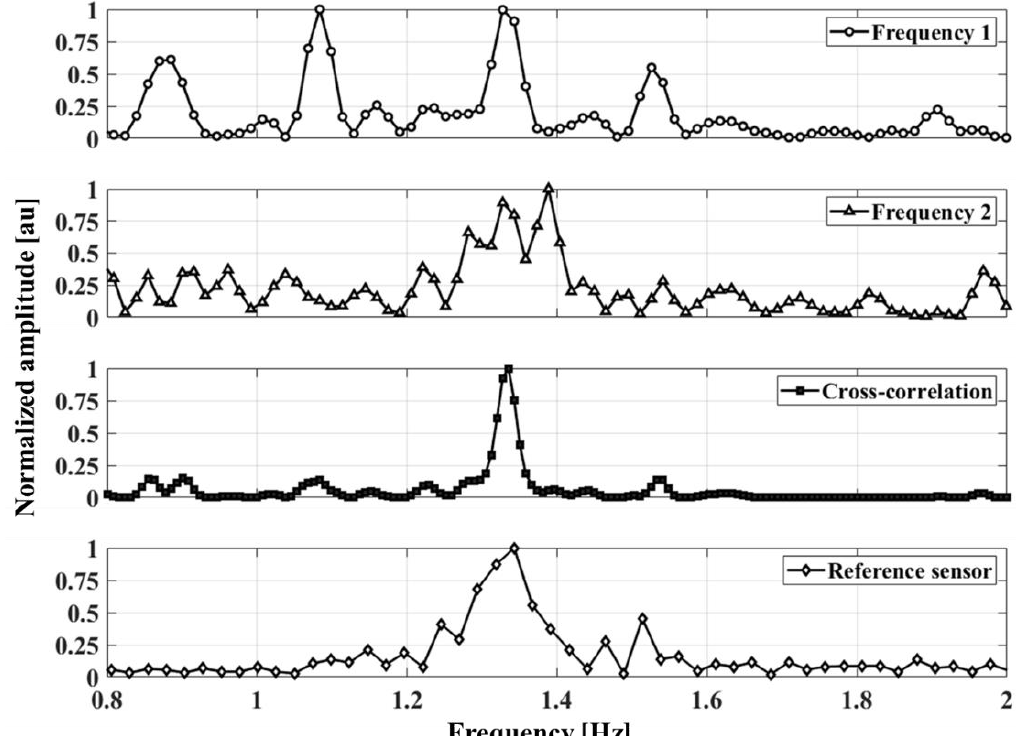
Figure 12. Spectra of the heartbeat signals measured by the proposed FSK radar at each operating frequency and with cross-correlation. The frequency peak of the cross-correlated signals is almost identical to that of the reference electrocardiogram (ECG) signals.